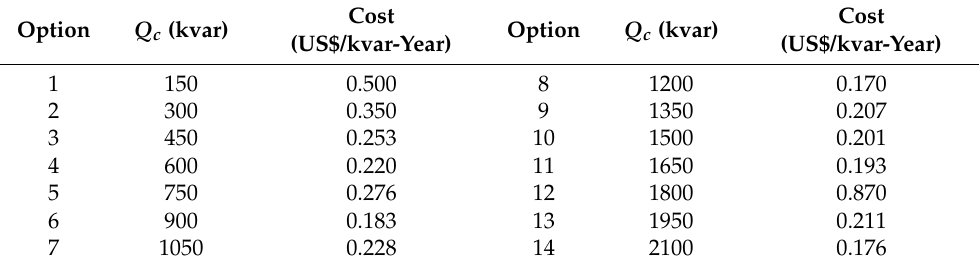
Table 3. Possible options of capacitors according to rate and cost.